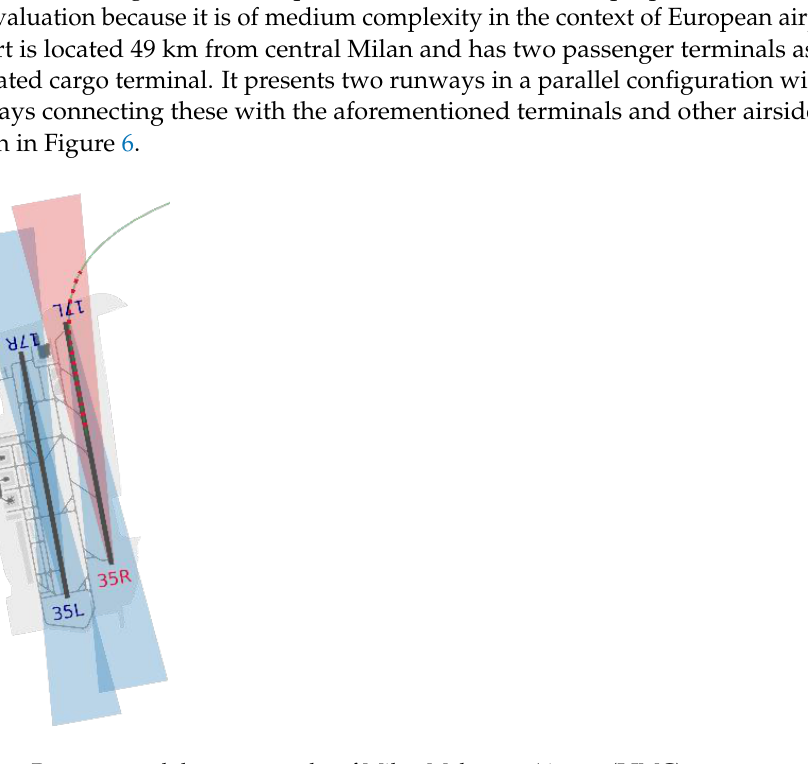
Figure 6. Runways and departure paths of Milan Malpensa Airport (LIMC).